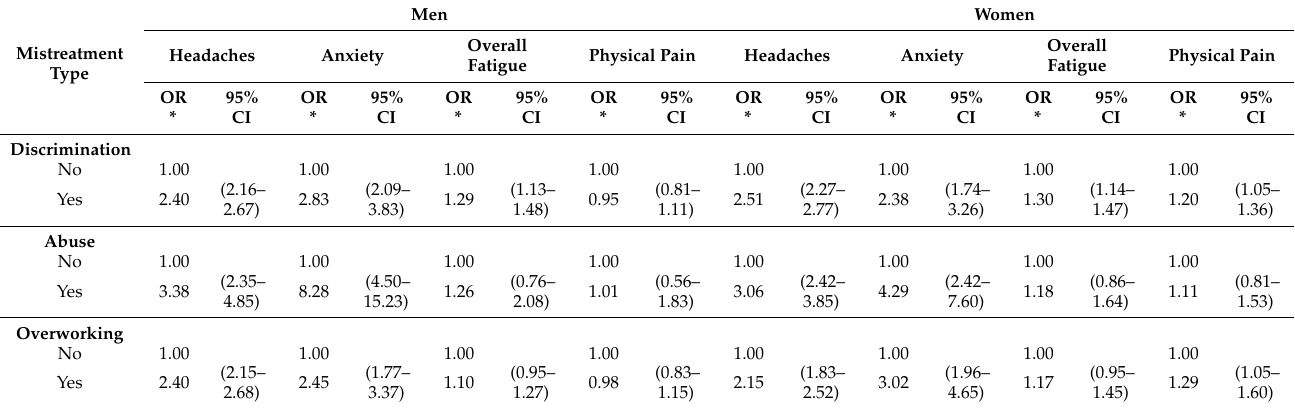
Table 2. Results of factors associated with having health problems in 2017 and 2020–2021.